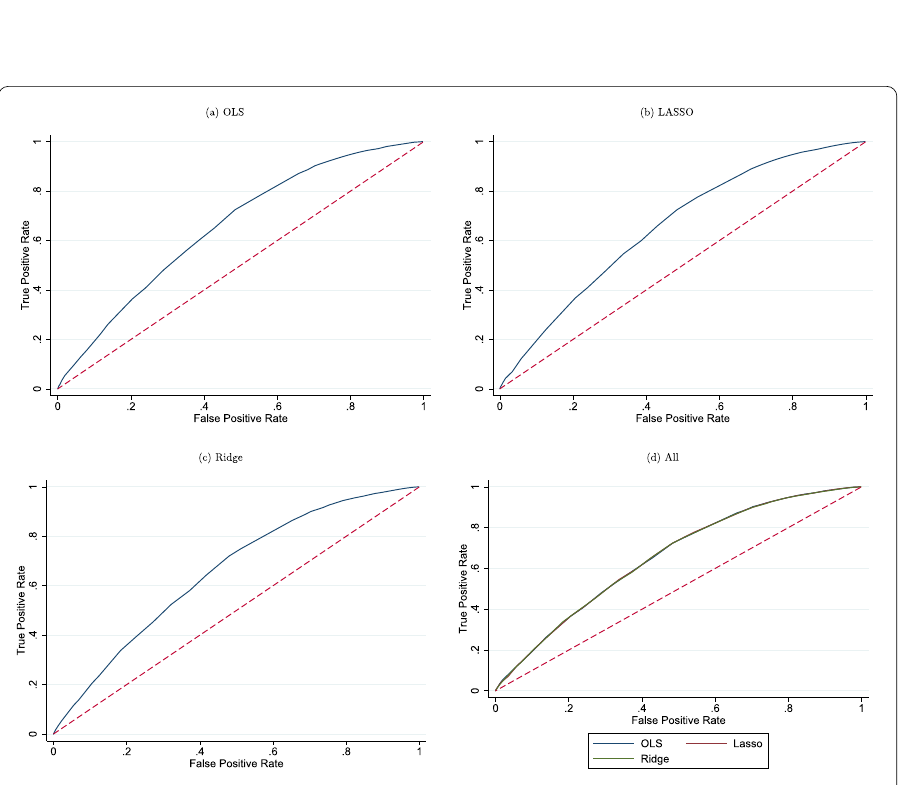
Figure A.4 ROC curves. Small model—main